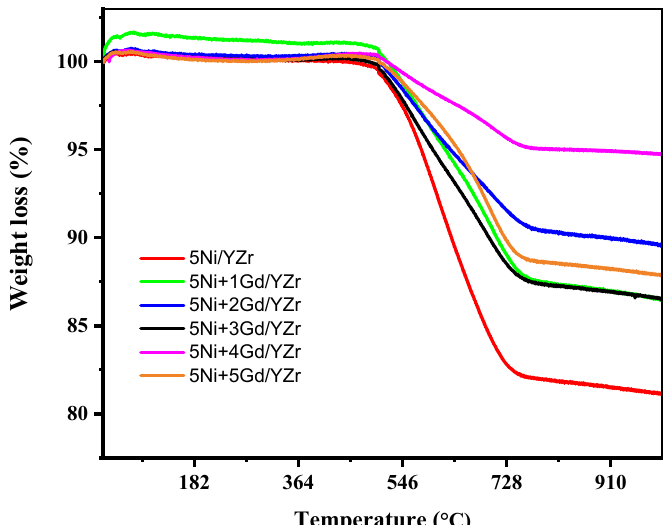
Figure 11. TGA plot of the spent catalysts after seven hours of time-on-stream.